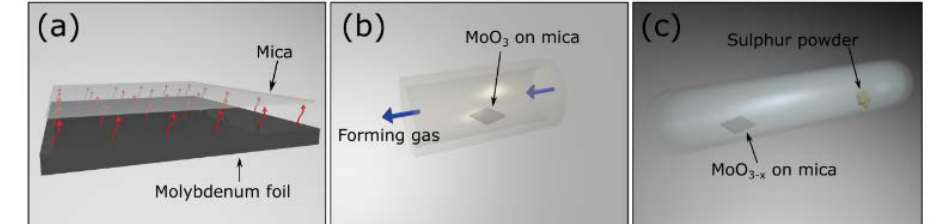
Figure 1. Cartoon of the process followed for the MoO 3 conversion into MoS 2 . ( a ) MoO 3 sublimes from a hot molybdenum foil (540 °C) and crystallizes onto a mica substrate. ( b ) MoO 3−x is formed after placing the MoO 3 in a tube furnace at 300 °C in a forming gas atmosphere for 24 h. ( c ) The sulfuration process is performed in a closed glass ampoule at 500–600 °C.